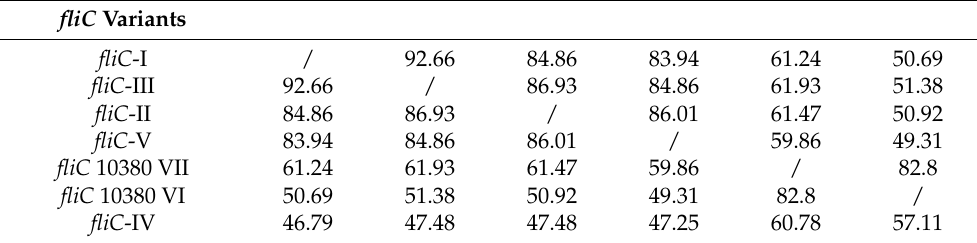
Table 3. Percent similarity matrix of the fliC type aminoacidic